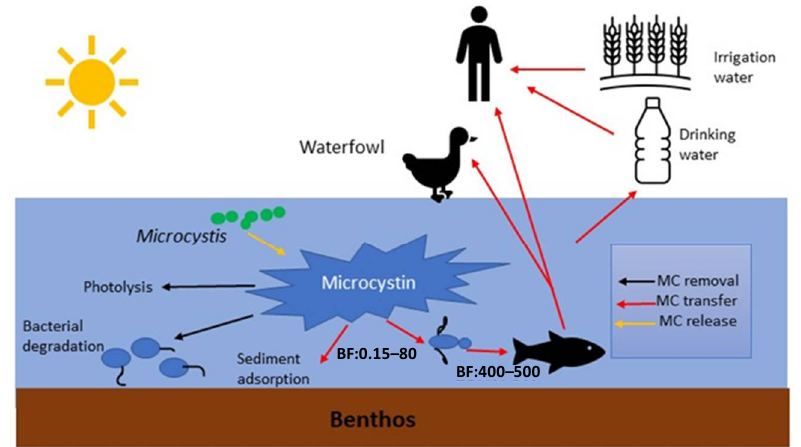
Figure 2. Schematic representation of MC-uptake, release, and transfer when in the environment. This schematic diagram represents the transfer of MCs from zooplankton to fish and finally humans.